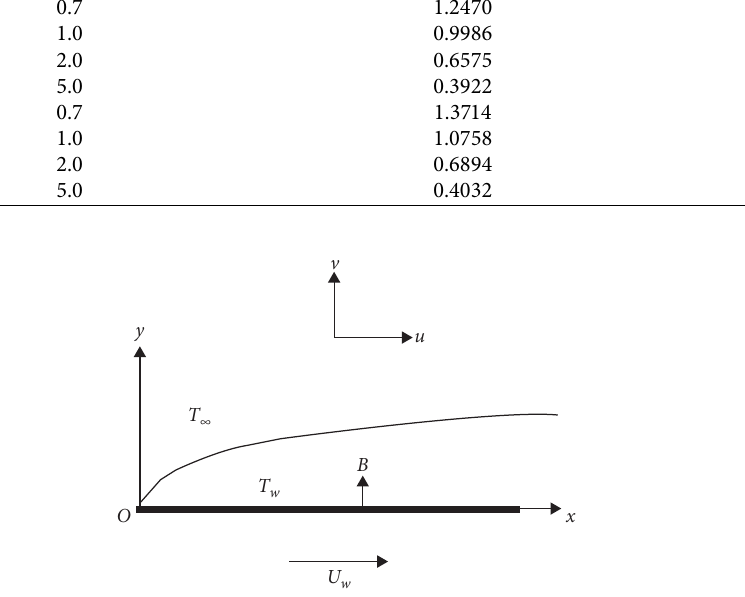
Figure 1: Physical model and coordinate system.